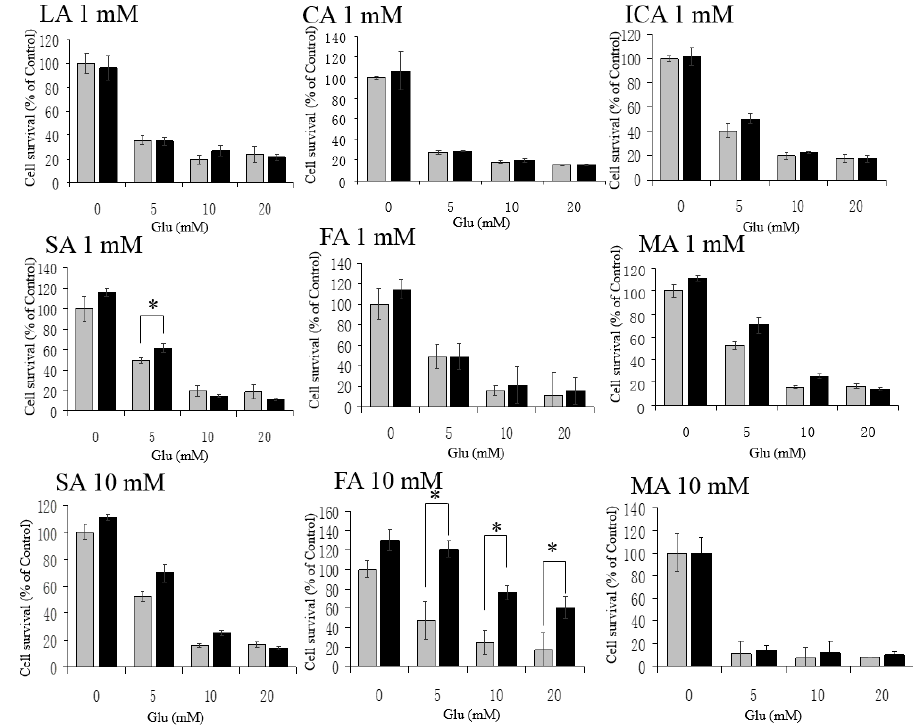
Figure 5. No protection of HT22 cells against Glu by the other KCIs at 1 mM. Neither LA, CA, ICA, SA, nor MA protected the cells against Glu used at 1 or 10 mM. FA at 10 mM protected the cells against Glu, although 1 mM FA did not. White bars indicate Glu alone, and gray bars Glu + KCI. Values, presented as a percentage of the control MTT value (obtained in the absence of glutamate), are given as the mean + SD ( n = 4). * significantly different ( p < 0.05) from samples without a KCI.